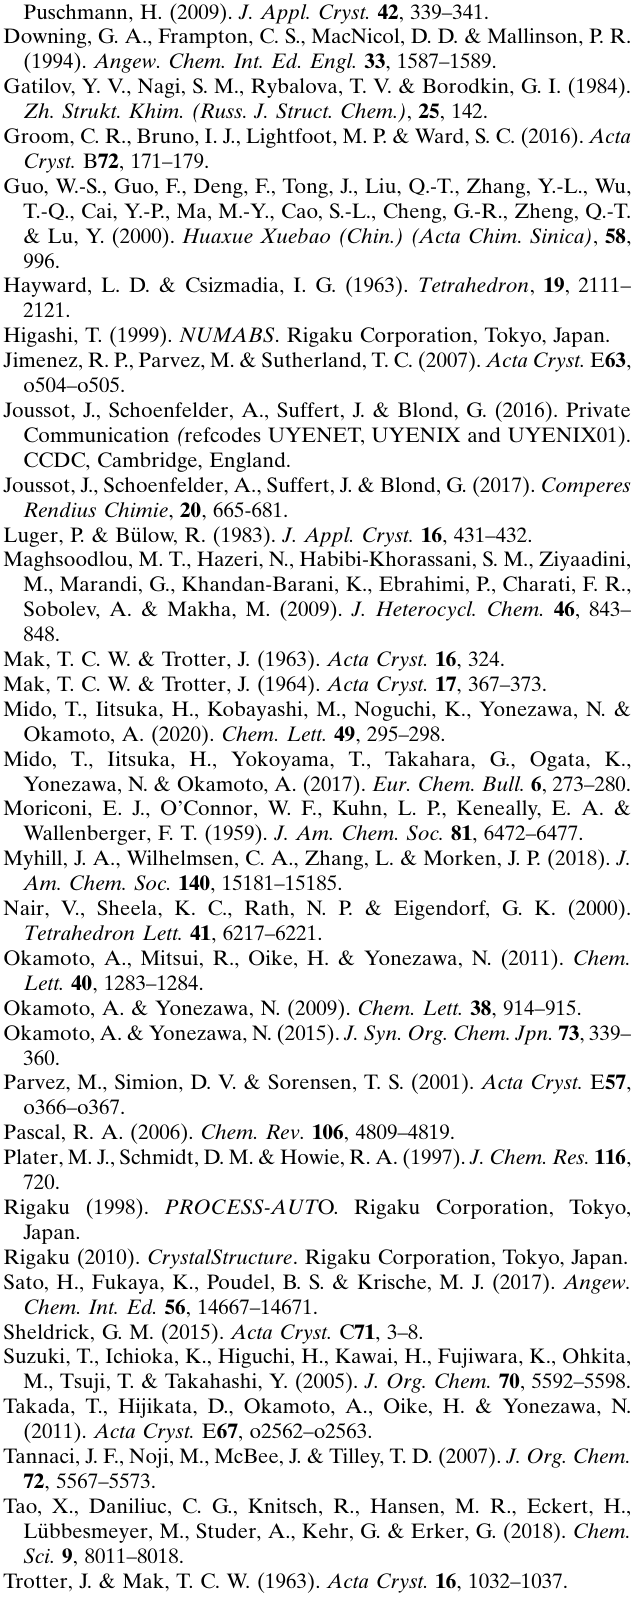
Table 2 Experimental details. Crystal data Chemical